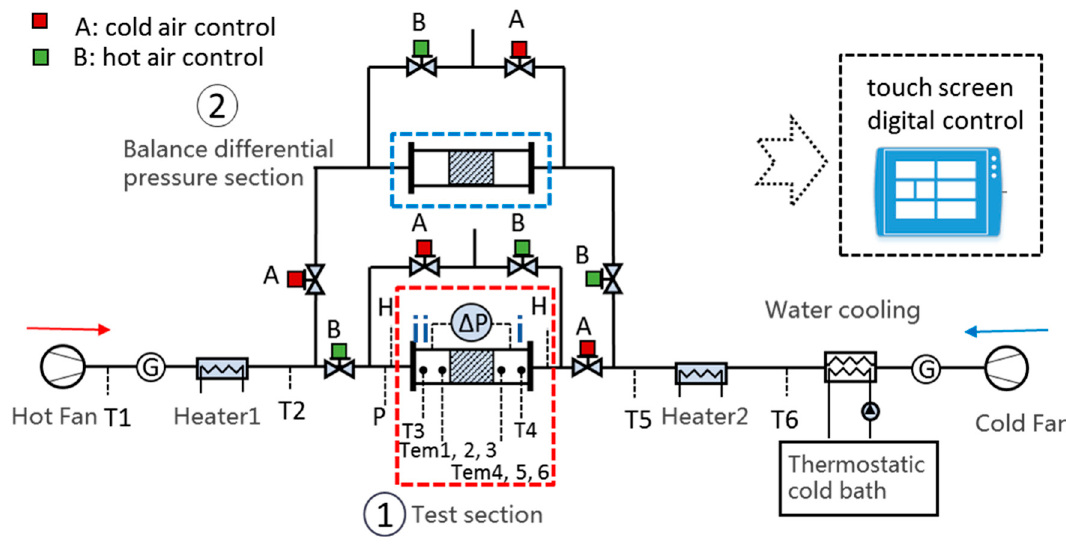
Figure 1. Schematic diagram of the experimental setup.